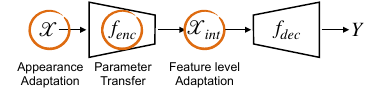
Figure 4. Parts of an abstract deep learning model f affected by different kinds of domain